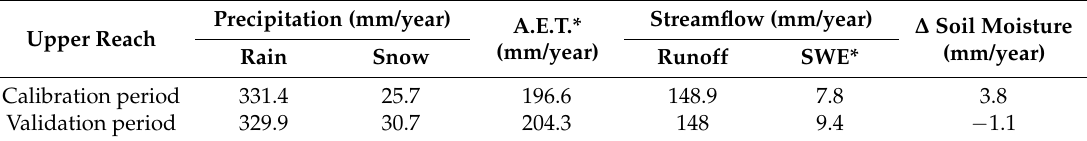
Table 5. Water balance status of the upper reach of Heihe River